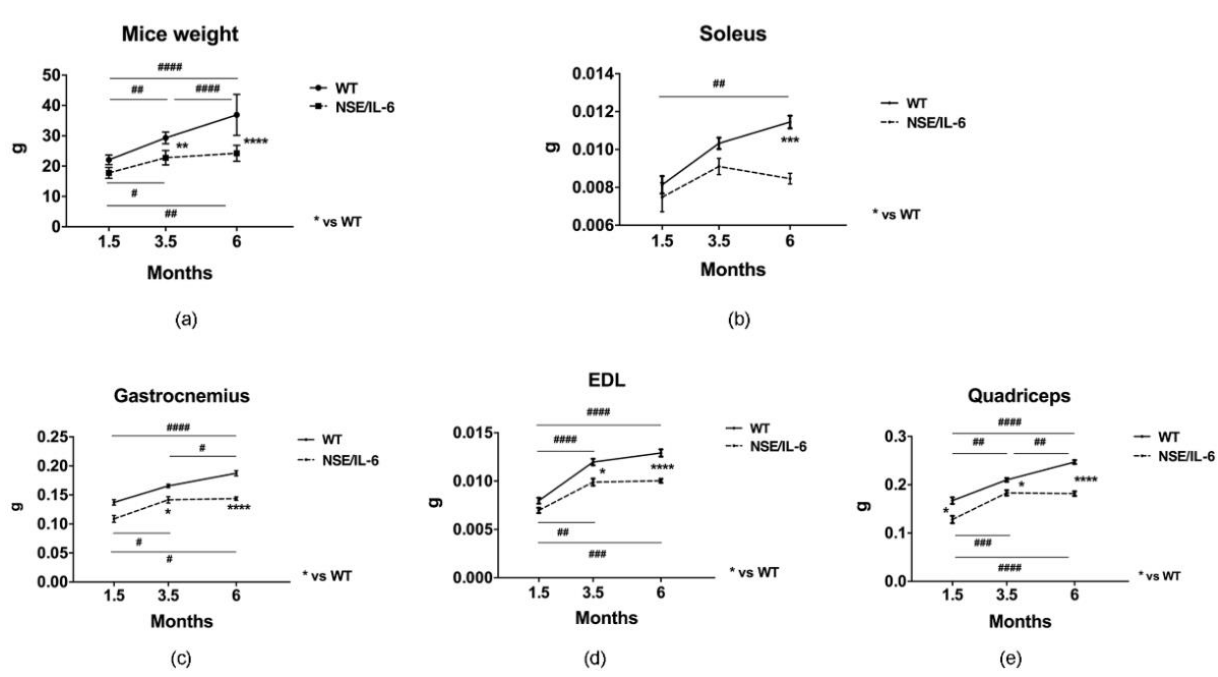
Figure 1. IL-6 overexpression affects muscle growth and size in distinct muscle groups. ( a ) Body weight growth curves. Wild type (WT) and NSE/IL-6 mice were measured to determine the change in body weight from 1.5 to 6 months of age. n = 9; ** p < 0.01, **** p < 0.0001, # p < 0.05, ## p < 0.01, #### p < 0.0001. ( b – e ) Growth curve of soleus ( b ), gastrocnemius ( c ), extensor digitorum longus (EDL) ( d ), and quadriceps muscles ( e ) of indicated genotype.. n = 12; * p < 0.05, *** p < 0.001; **** p < 0.0001, # p < 0.05, ## p < 0.01, ### p < 0.001, #### p < 0.0001. All measurements are presented as means ± SEM. Statistical significance assessed by two-way ANOVA followed by multiple comparisons